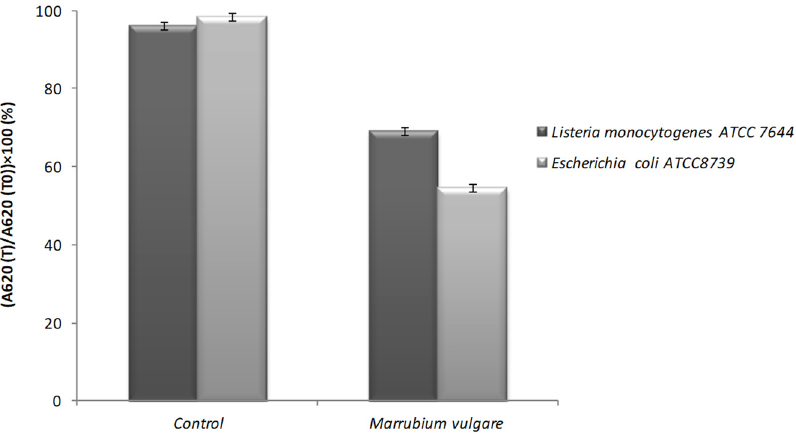
Figure 3. Cell integrity of E. coli (grey bars) and L. monocytogenes (black bars) after treatment by methanolic extract of M. vulgare at concentration corresponding to MIC. The results are expressed as the ratio of the absorbance measured at time T to the absorbance at 620 nm measured at time zero ((OD 620 (T)/OD 620 (T 0 )) × 100).